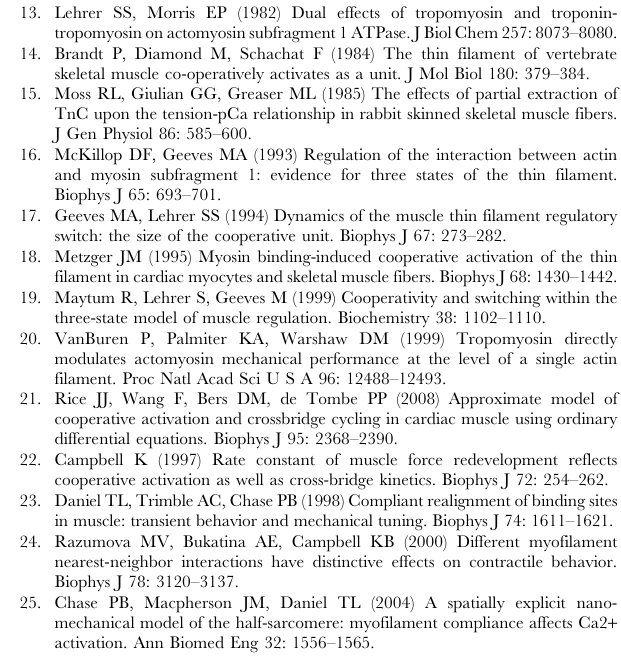
Figure S4 Model sensitivities to cooperative parameters Y and j . Values from 3 parameter Hill fits to steady-state force-pCa relationships demonstrate the influence of Y and j on coopera- tivity ( n H , the top set of panels), Ca 2 + sensitivity ( pCa 50 , the middle set of panels), and the maximal rate of force development ( k dev , the bottom set of panels). All simulations used standard parameter values of k xb = 3 pN nm 2 1 , k fil = k m = k a =1X, RU span = 9 actins. All possible forms of cooperativity were implemented as Y varied from 1 to 1000, with j fixed at 100 (A–C). All possible forms of cooperativity were implemented as Y varied from 1 to 2000, with j = Y for each simulation (D–F). RU-RU and XB-XB coopera- tivity were implemented as Y varied from 1 to 2000, with j = Y for each simulation (G–I). Error bars represent 95% confidence intervals on the fitted parameter values for n H and pCa 50 , and SE for k dev . (PDF) Text S1 Although many of our findings were discussed in the primary manuscript, additional simulation results described in Text S1 provide a more complete picture of cooperative thin filament activation kinetics on the force-pCa and fraction available-pCa relationships (Figure S2), the rate of thin filament activation ( k TF,act , Figure S3), and range of cooperative force-pCa relationships as Y and j co-varied (Figure